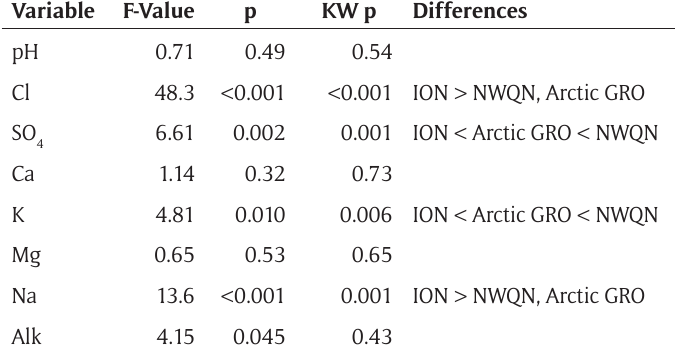
Table 7: Summary of Two-way analysis of variance (ANOVA) comparing the collector groups with the interaction of sampling years. If significant differences were found, the “Differences” column indicates which specific differences were significant. [F-value, F-statistic associated with ANOVA; p, probability; NWQN, National Water Quality Network; Arctic GRO, Arctic Great Rivers Observatory; ION, Indigenous Observation Network; Early, 2007–08 combined with 2009–10; Mid, 2013–14; <, less than; >, greater